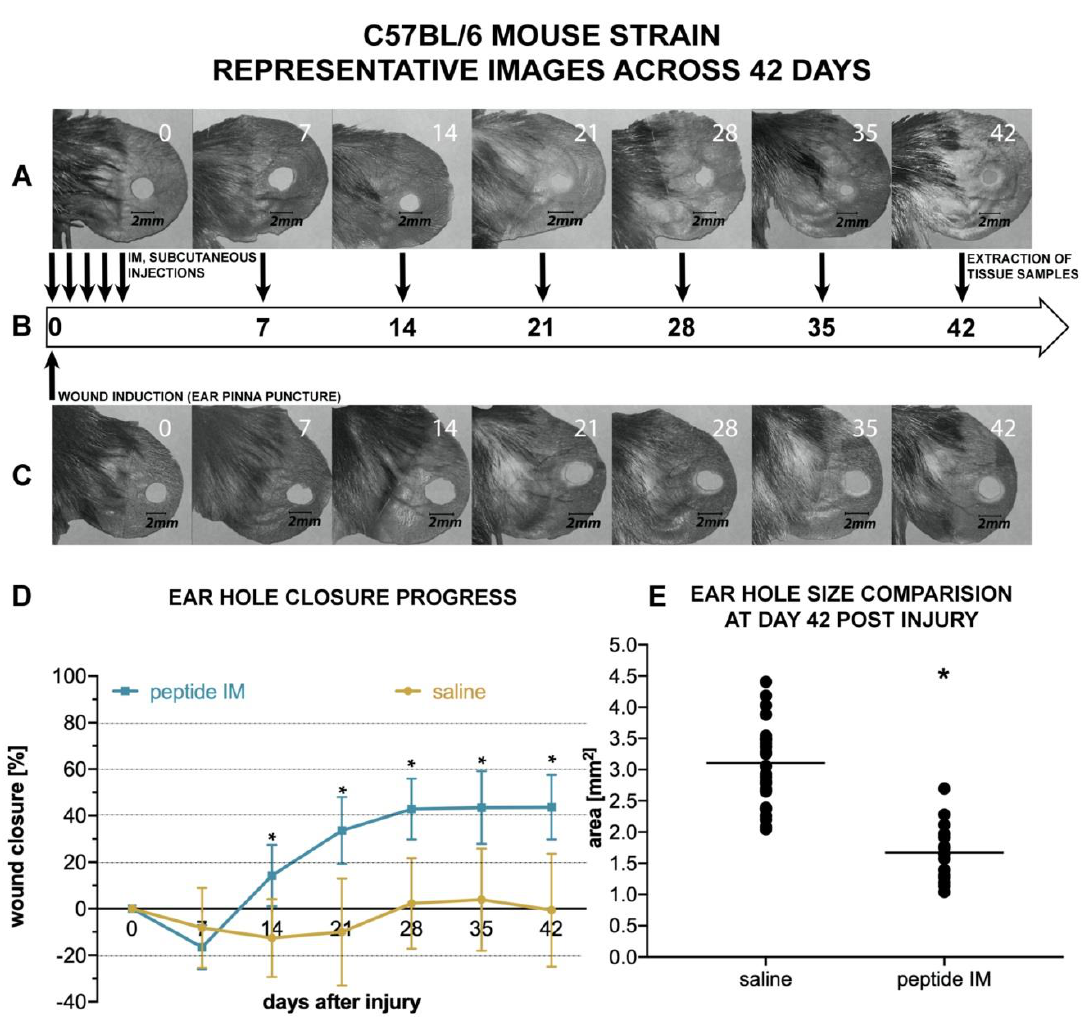
Figure 7. E ff ect of subcutaneous IM injections on ear punch closure in mice of the C57BL / 6 strain. ( A , C ) representative photographs of healing ear pinnae in C57BL / 6 mice injected with saline or IM. ( A ) the treatment group (IM injections; n = 8 mice) and ( C ) the control group (saline injections; n = 18 mice). ( B ) the timeline of experiments and injection intervals. The scale bar is calibrated in mm. ( D ) the mean area of C57BL / 6 mice ear holes throughout the experiment; error bars represent SD; and statistical significance * means p ≤ 0.05. ( E ) shows the distribution of ear hole area at 42 days post injury in the C57BL / 6 mice strain. Each dot represents one ear hole, and the black line represents the mean value.